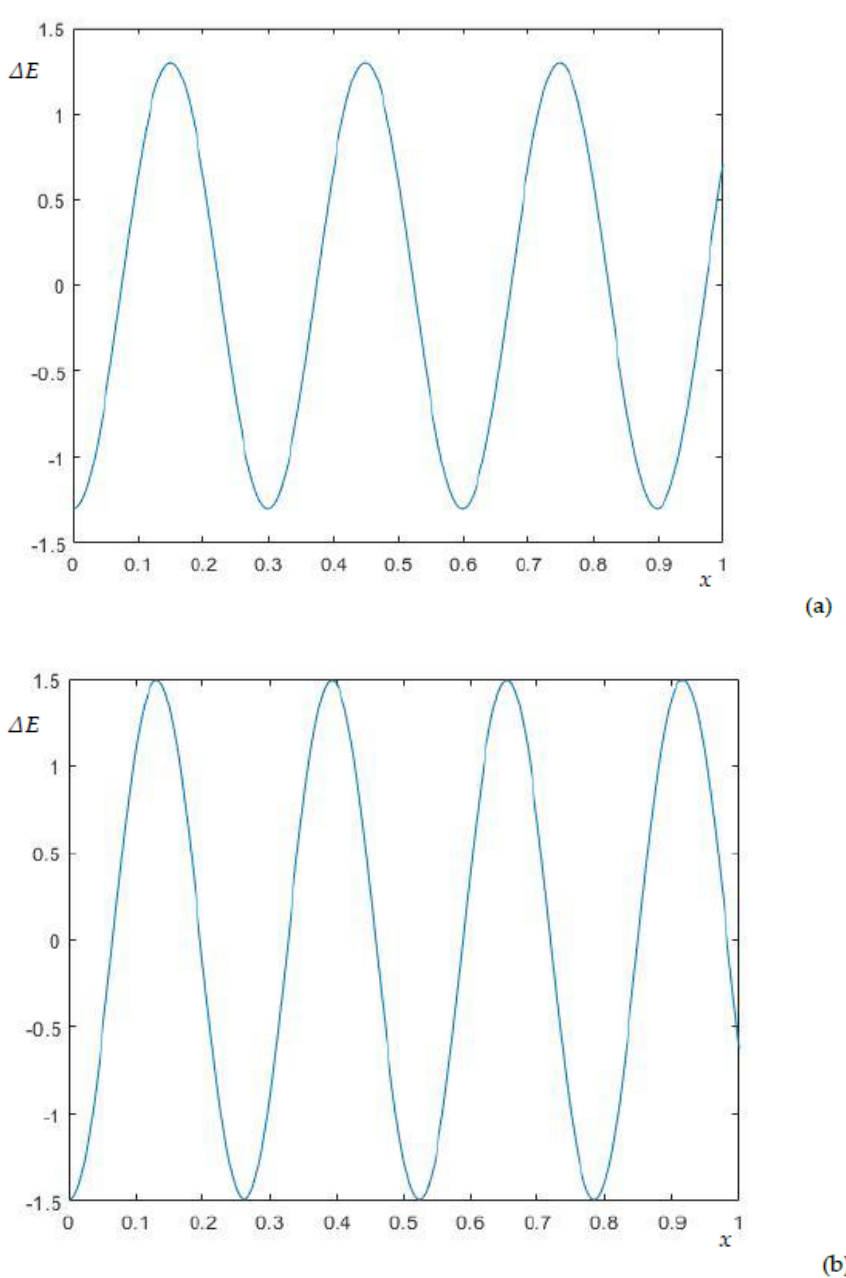
Figure 6. Graph of the equation of the II state in the inactivated state with different parameters ( a , b ). Stable self-oscillating process at a certain level of activity/energy. The Y axis represents the change in potential energy/activity ( ∆ E ) of the II, X axis is x —a conditional coordinate in the space of information